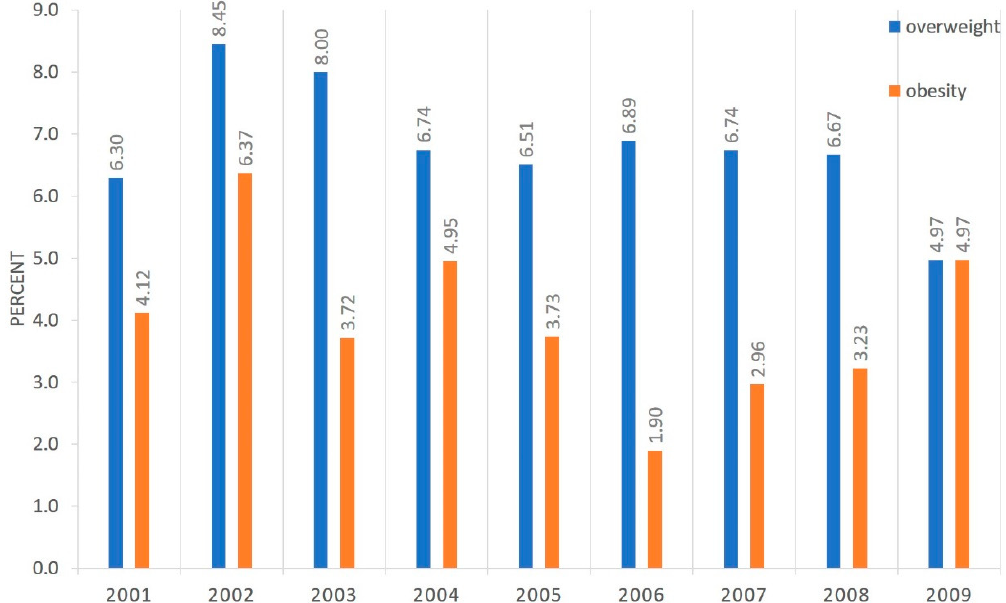
Figure 3. Prevalence of overweight and obesity in boys at age 6–7 by birth year.